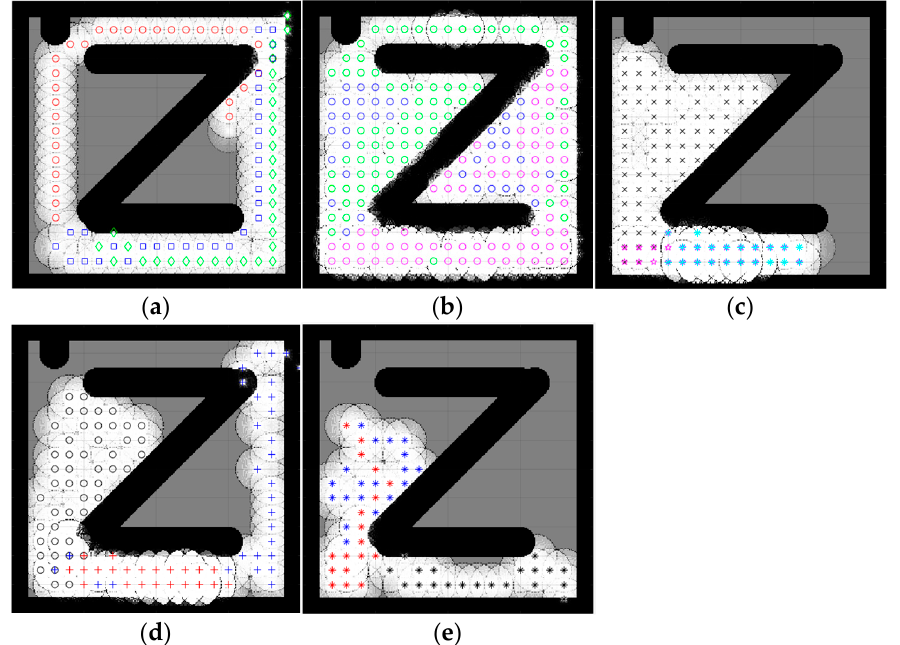
Figure 11. Percentage of the explored area after implementing the CME-SSA and the other ap- proaches on complex map 5. Complex map 5: ( a ) CME, 54.23% (Iteration 31); ( b ) CME-SSA, 96.59%; ( c ) CME-GWO, 53.85% (Iteration 51); ( d ) CME-GWOSSA, 58.32% (Iteration 58); ( e ) CME-SCA, 44.56% (Iteration 49).